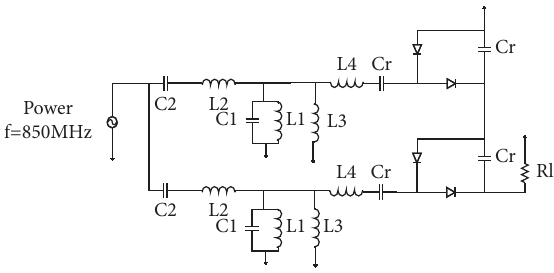
Figure 35: Rectifer with the second branch of